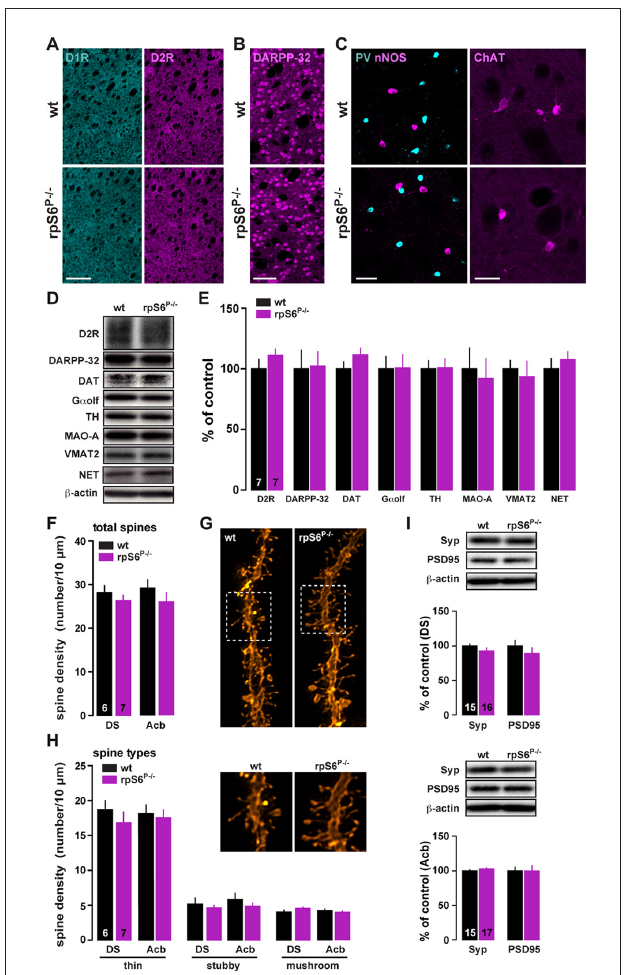
FIGURE 2 | Striatal dendritic spines density and protein expression in rpS6 P − / − mice. (A) Single immunostaining for D1R (cyan) and D2R (magenta) in coronal sections of the striatum from wt (top) and rpS6 P − / − (bottom) mice. Scale bar: 250 µ m. (B) Single immunostaining for DARPP-32 of the striatum from wt (top) and rpS6 P − / − (bottom) mice. Scale bar: 60 µ m. (C) Double immunostaining for nNOS (magenta) and parvalbumin (PV, cyan; left panel) or single immunofluorescence for choline acetyltransferase (ChAT; right panel) in the striatum of wt (top) and rpS6 P − / − (bottom) mice. Scale bar: 40 µ m and 20 µ m. (D) Representative western blots and (E) quantified signals of D2R, DARPP-32, DAT, G α olf, TH, MAO-A, VMAT2 and NET normalized to β -actin in whole striatal lysates from wt (black bars) and rpS6 P − / − (magenta bars) mice. Results are represented as mean ± SEM ( n and p values in Supplementary Table S1:2e). (F) Total number of spines per 10 µ m in DS and Acb MSNs of wt (black bars) and rpS6 P − / − (magenta bars) mice. (G) Representative dendrites spines visualized by fluorescent dye DiI. (H) Density of thin, stubby or mushroom dendritic spines were analyzed on a subset of dendrites in DS and Acb MSNs of wt (black bars) and rpS6 P − / − (magenta bars) mice. The number of animals in each condition is indicated in the bars. Results are represented as mean ± SEM ( n and p values in Supplementary Table S1:2g,h). (I) Representative western blots and quantified signals of Syp and PSD95 normalized to β -actin in DS (TOP) and Acb (bottom) lysates from wt (black bars) and rpS6 P − / − (magenta bars) mice. Results are represented as mean ± SEM ( n and p values in Supplementary Table